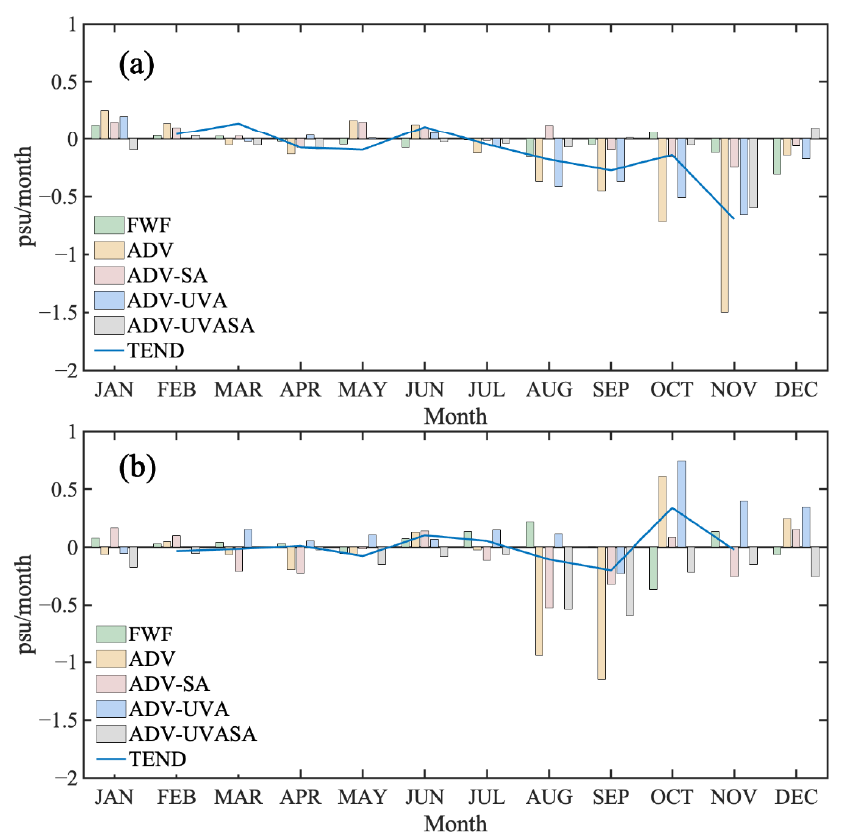
Figure 7. Anomalous salt budget terms for ( a ) region 1: the Sri Lanka region (75 – 85°E, 5 – 12°N) and ( b ) region 2: the northern BoB region (86 – 94°E, 15 – 21°N) in 2010. ( b ) region 2: the northern BoB region (86–94 ◦ E, 15–21 ◦ N) in